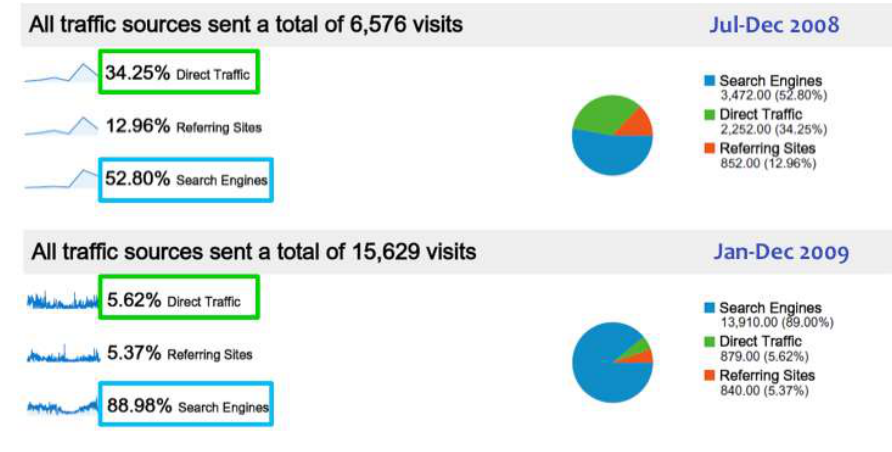
Figure 7: Traffic sources towards the IDEAL-EU SNP